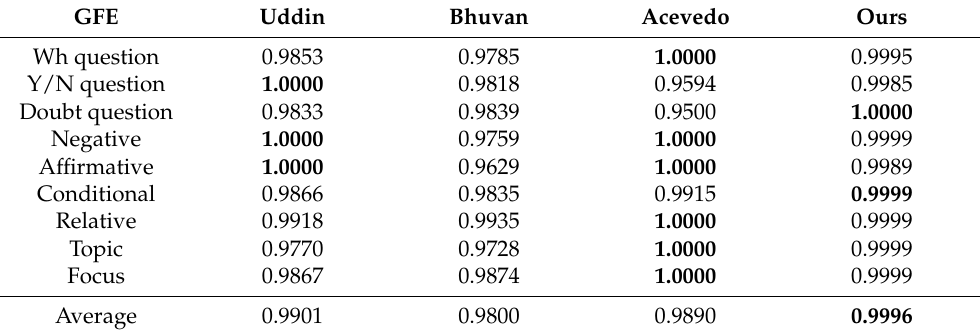
Table 7. ROC-AUC scores achieved by our proposed model and other state-of-art approaches using a dataset storing grammatical facial expressions of the Brazilian sign language (Libras) made by subject one and subject two. Best results are in bold.